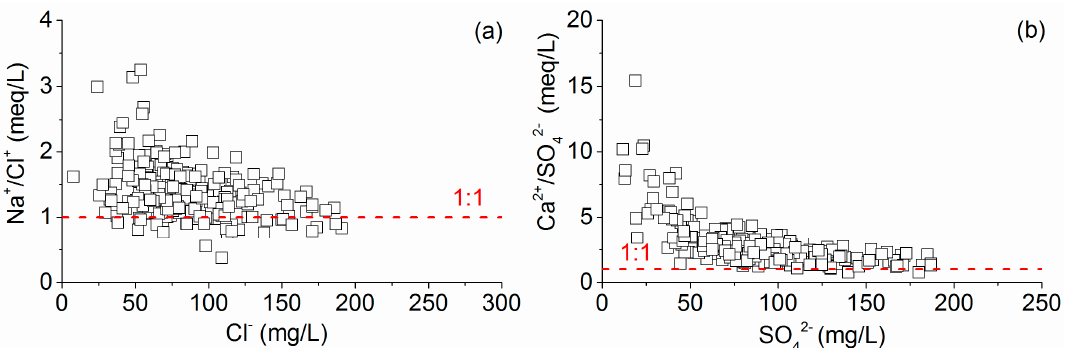
Figure 4. Bivariate diagrams of carbonate weathering and dissolution ( a ), calcite and dolomite weathering and dissolution ( b , c ).